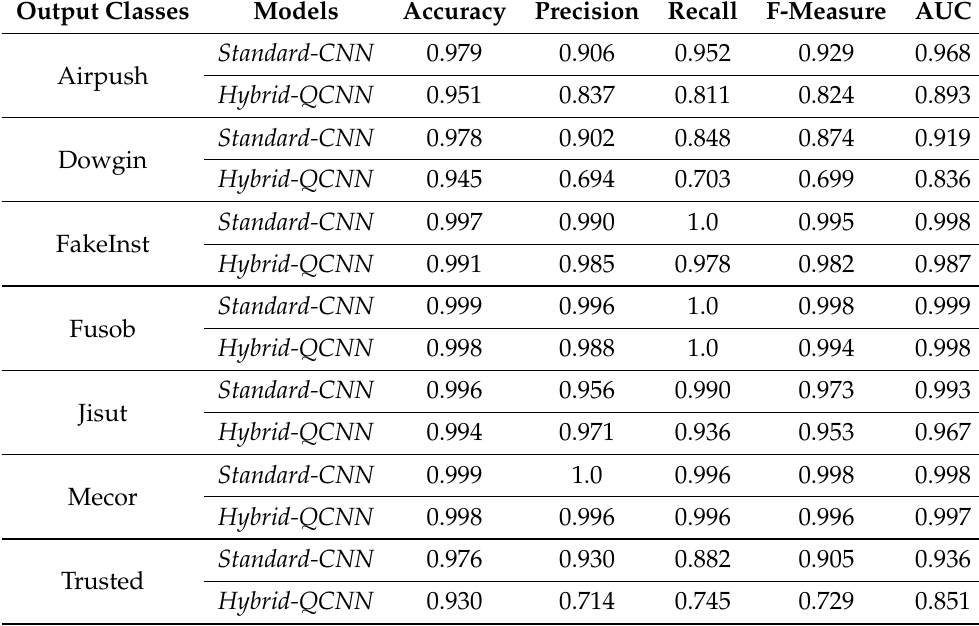
Table 3. Experimental results obtained with the convolutional and the quantum model obtaining the best performances for the family classification